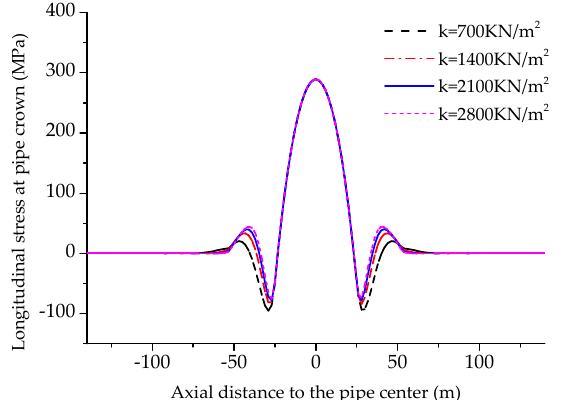
Figure 18. Longitudinal stresses at pipe crown for pipes with various wall thicknesses.